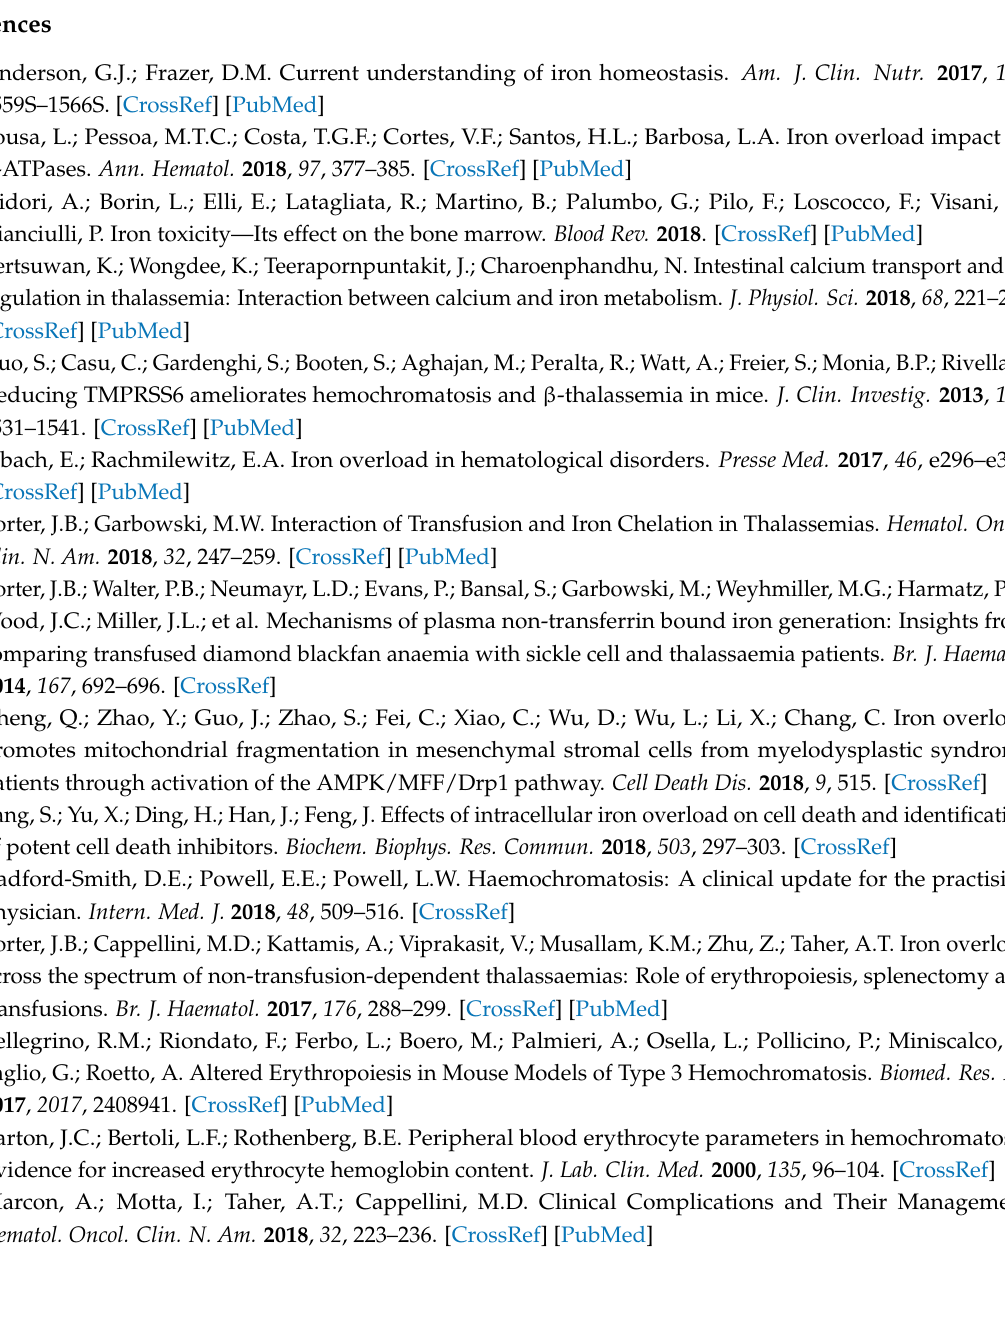
Figure S1: The profile of cytokine production in the media culturing MS5